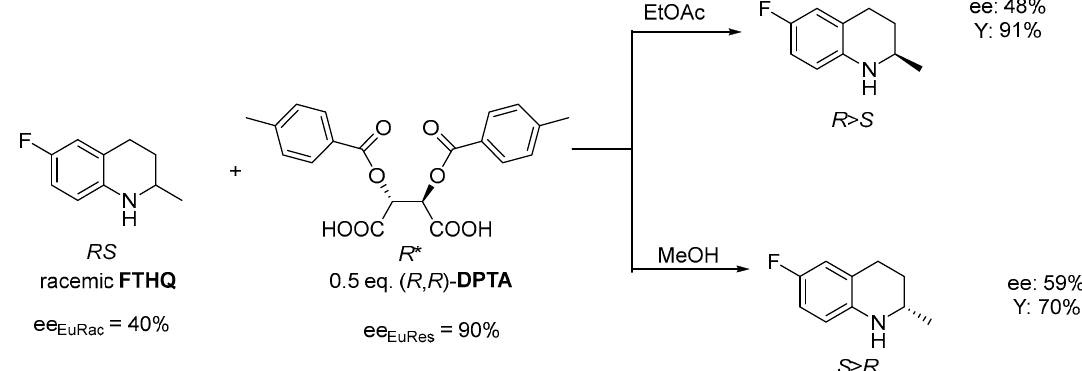
Figure 10. The composition of the diasteromer can be influenced and predetermined by the variation of the solvent.